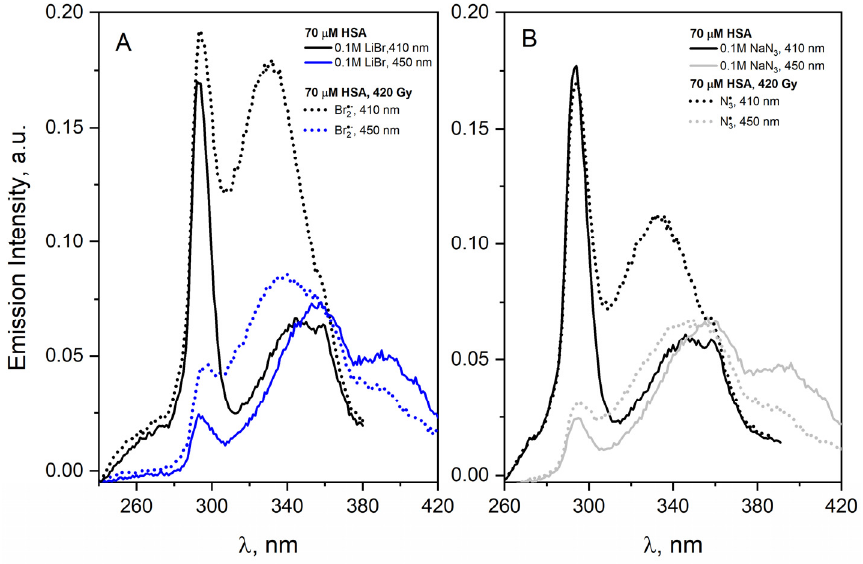
Figure 18. Emission excitation spectra of the N 2 O-saturated HSA solutions (70 µM) containing 0.1 M LiBr ( A ) or 0.1 M NaN 3 ( B ), recorded before and after irradiation with a dose of 420 Gy. The emission detection wavelengths are 410 and 450 nm.